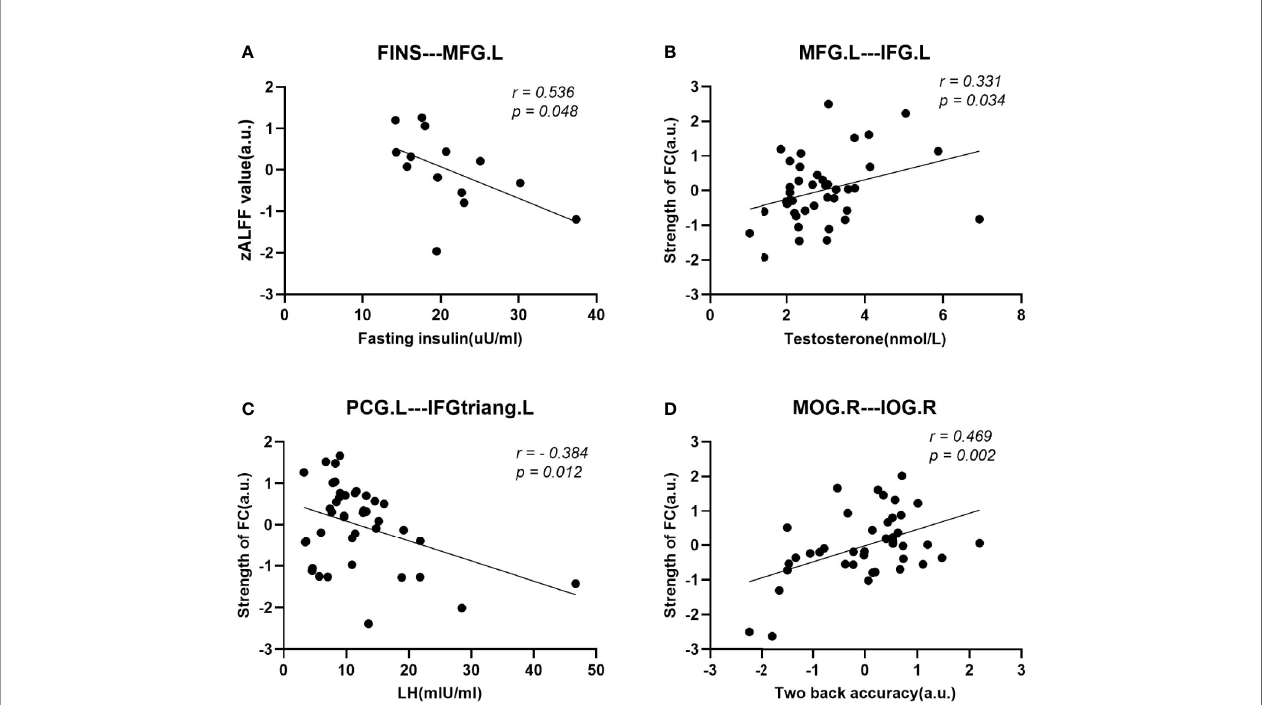
FIGURE 5 | Scatter diagrams showing the signi fi cant correlations between aberrant ALFF values, FC strengths, clinical data, and neuropsychological assessments of women with PCOS in (A – D) . (A) The decreased ALFF value in the MFG.L was negatively correlated with the fasting insulin (FINS) within insulin resistant subjects. (B) The enhanced FC strength between the MFG.L and IFG.L was positively correlated with the plasma T level. (C) The enhanced FC strength between the PCG. L and the IFGtriang.L was negatively correlated with the luteinizing hormone (LH). (D) The accuracy rate (ACC) in the two-back task was positively correlated with the decreased FC strength between the MOG.R and the